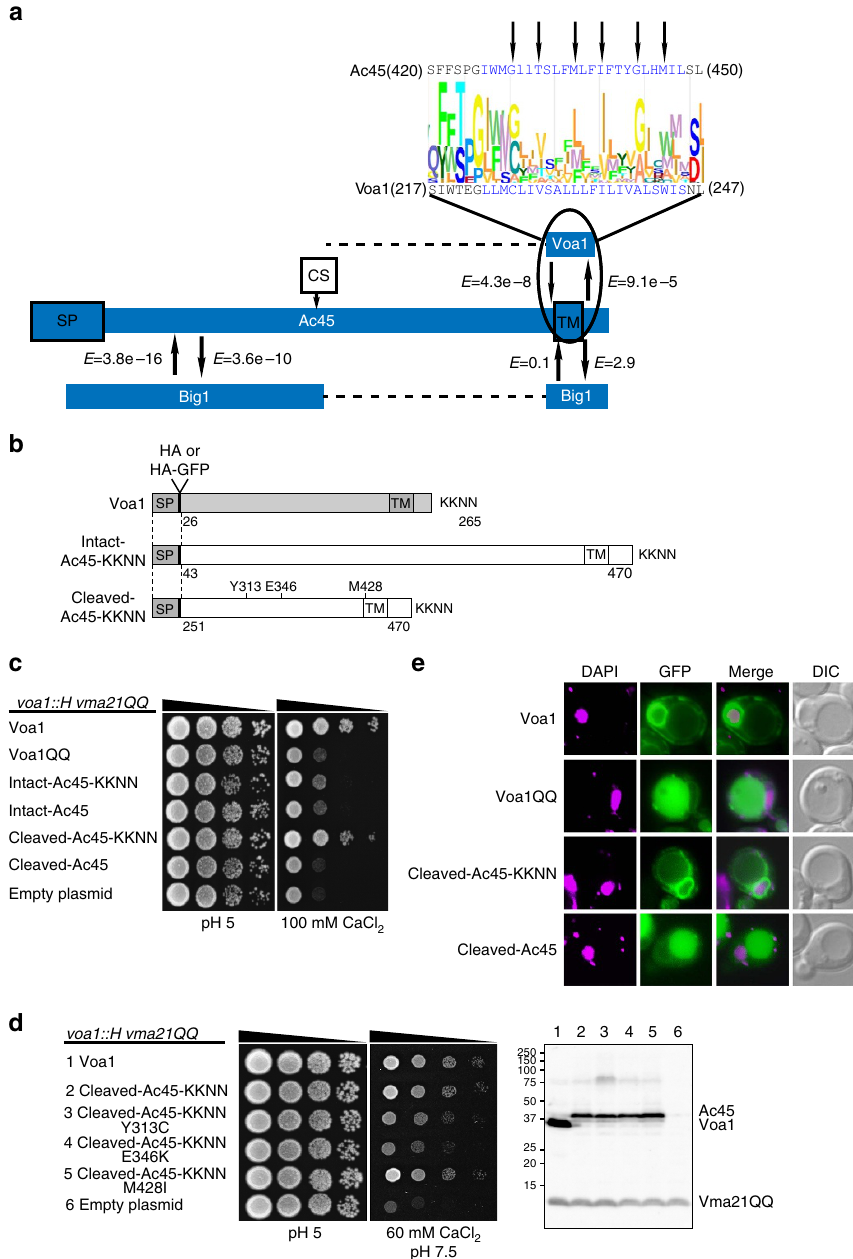
Figure 5 | Identification of Voa1 as the yeast ortholog of human Ac45. ( a ) Overview of the regions of Ac45 that are homologous to the yeast proteins Voa1 and Big1 and an alignment of Ac45’s and Voa1’s C-terminal transmembrane helices (in blue, based on TMHMM 63 ) and their flanking amino acids. Ac45 and Voa1 are separated by a sequence logo representation of this region among all the homologs that could be detected using JACKHMMER 64 . A pattern in which the level of sequence conservation in the transmembrane helix peaks every 3–4 amino acids is indicated with arrows. ( b ) Schematic of Voa1 and Ac45 proteins expressed from centromere plasmids in voa1::H vma21QQ yeast 24 . Ac45 proteins are either full length (intact-Ac45) or processed (cleaved-Ac45), with (shown) or without KKNN appended to the natural C terminus. Numbers indicate amino-acid residues. Residues mutated in Ac45 are shown. ( c ) Cleaved-Ac45 can substitute for Voa1 when a C-terminal dilysine motif is present. The voa1::H vma21QQ strain was transformed with plasmids coding for the indicated proteins (HA-tagged, diagrammed in ( b )), Voa1QQ denotes Voa1 with K262Q and K263Q mutations. ( d ) The Y313C or E346K mutation in cleaved-Ac45-KKNN reduces V-ATPase function while protein levels are unaffected. Serial dilution growth test of voa1::H vma21QQ yeast expressing the indicated proteins tagged with HA. Restrictive growth is on rich medium adjusted to pH 7.5 and supplemented with 60mM CaCl 2 . Membrane proteins prepared from the same cultures used in the growth test were analysed by western blot using anti-HA antibody to detect Voa1, cleaved-Ac45-KKNN and its mutant forms (band locations marked on the right, molecular mass (kDa) is indicated on the left. ( e ) Voa1 and cleaved-Ac45 require a C-terminal dilysine motif for ER localization. Fluorescent microscopy of live yeast cells showing DAPI stained DNA, GFP, the merged image of both, and cells viewed by differential interference contrast (DIC) to locate the vacuole as apparent indentation. The indicated proteins are N-terminally tagged with HA-GFP and expressed in voa1::H vma21QQ yeast cells. Exposure times for GFP images of cleaved-Ac45 were 10 (cid:3) longer than for Voa1 or Voa1QQ. Perinuclear GFP fluorescence indicates ER localization. Mutated and non-mutated cleaved-Ac45-KKNN show the same localization. See also Supplementary Fig.